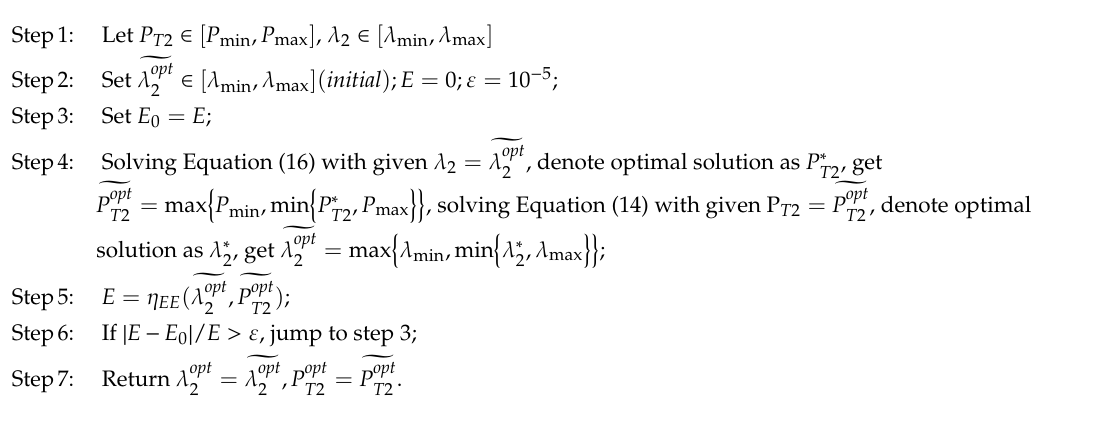
Algorithm 1. Alternating Optimization of Density and Transmit